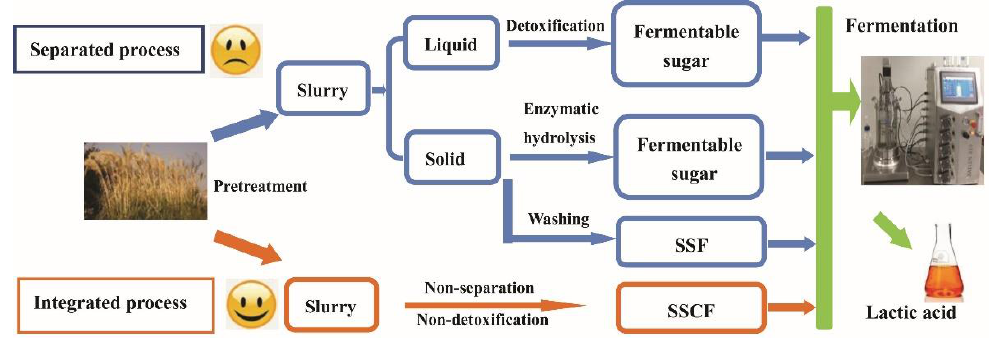
Figure 5. A schematic diagram of the separated process and the integrated process.